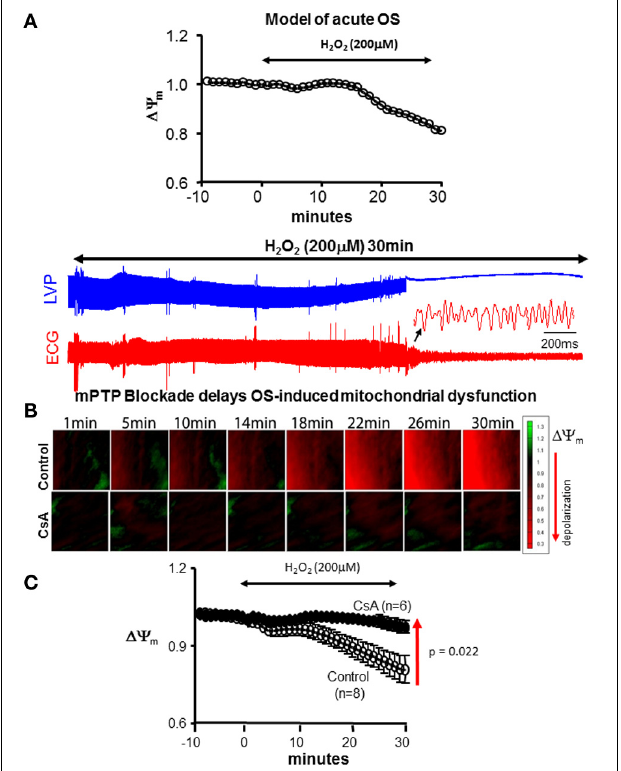
FIGURE 1 | CsA delays OS-induced mitochondrial and contractile dysfunction. (A) Model of acute OS. Continuous 200 μ M H 2 O 2 perfusion for 30min leads to (cid:2)(cid:3) m depolarization and initiation of VF. (B) Sequences of isopotential contour maps depicting the spatio-temporal distribution of (cid:2)(cid:3) m in representative control (untreated) and CsA-treated hearts following challenge with H 2 O 2 (200 μ M) for 30min. (C) Average (cid:2)(cid:3) m response to acute OS in all control and CsA treated